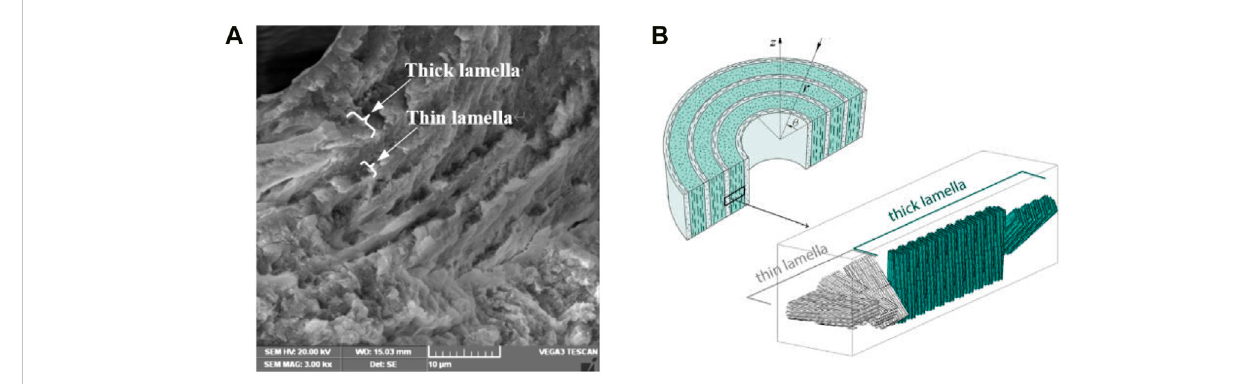
FIGURE 1 Lamella structure of osteon. (A) Thin and thick lamellae of osteon, (B) arrangement direction of fi bers in adjacent